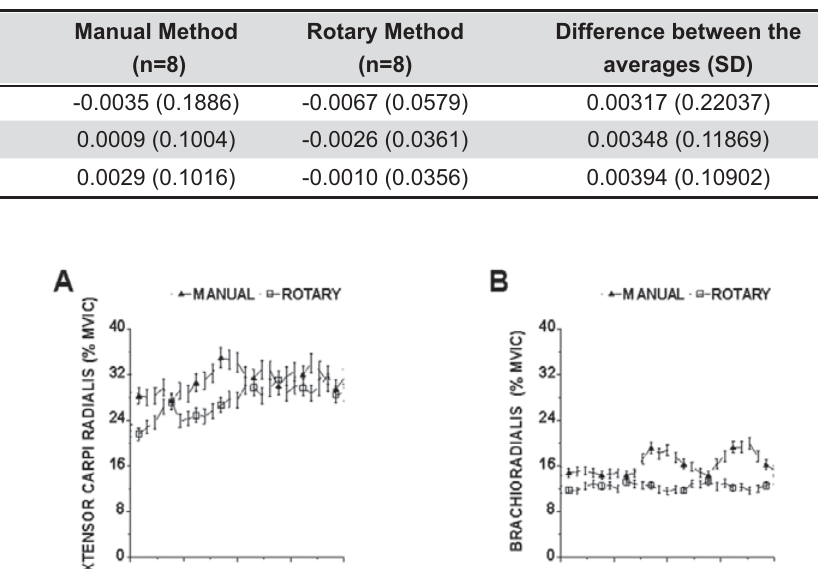
Table 2- Joint torque values normalized to each subject´s body weight for the shoulder, elbow, and wrist (Nm/kg) during the moviments for the preparation of simulated root canals with manual and rotary instruments. Average values expressed in Nm/kg and standard deviation. The positive and negative values represent the clockwise and counterclockwise directions respectively